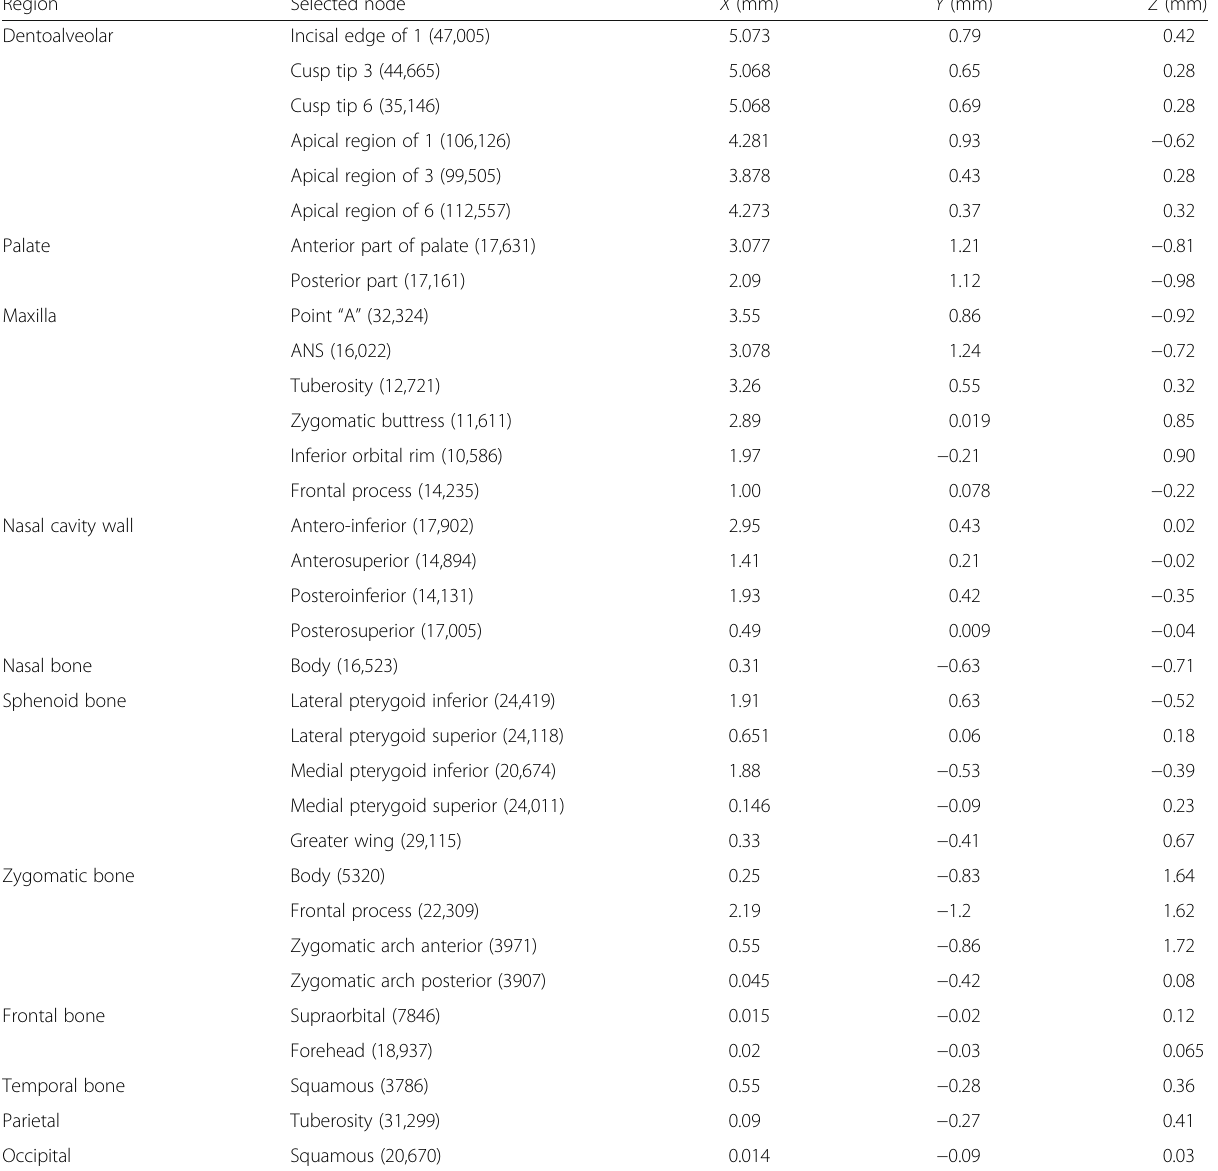
Table 1 Computational result of the transversal (X), sagittal (Y), and vertical (Z) displacements of the various skeletal structures of the craniofacial complex following 5 mm of transverse expansion on application of 19 kg/mm 2 force Region